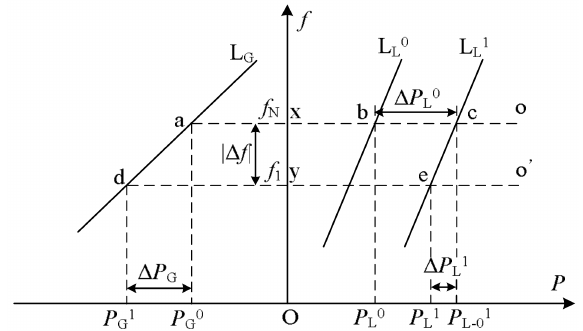
Figure 4. S-L analysis method of single-supply